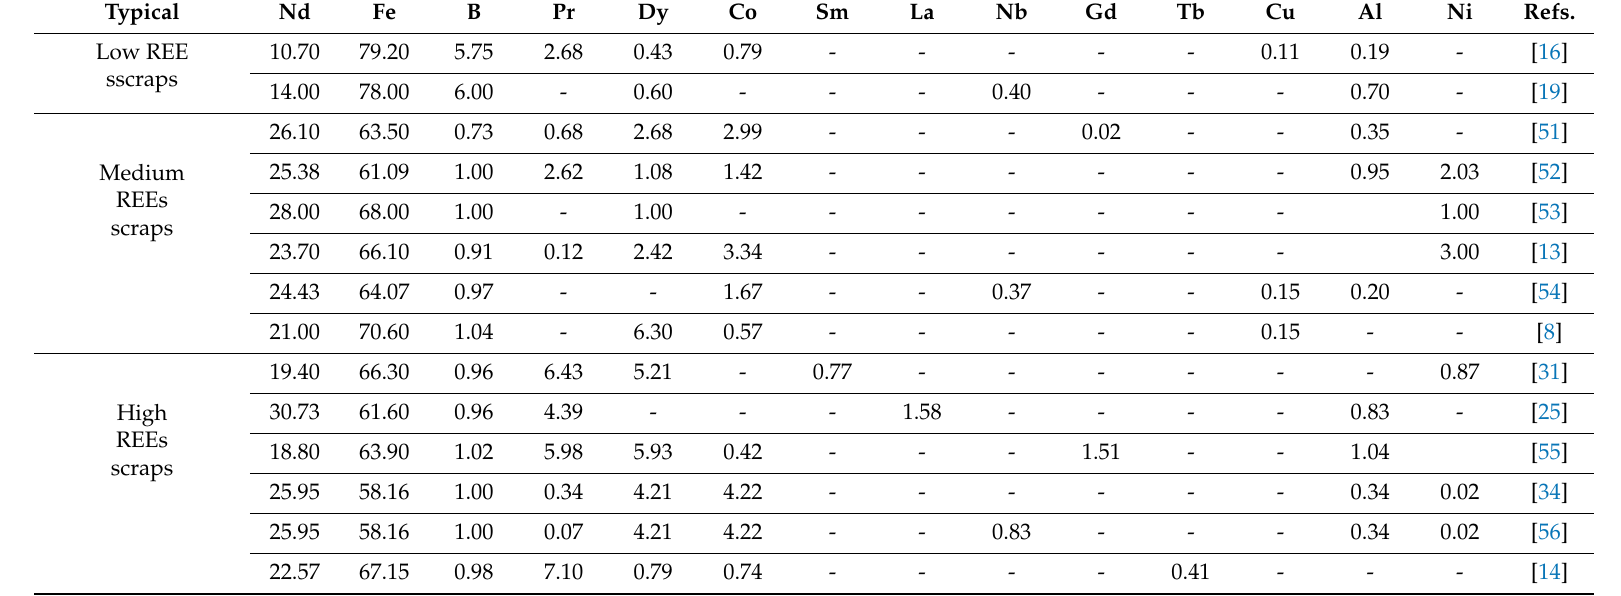
Table 2. Typical chemical compositions of NdFeB magnet scrap